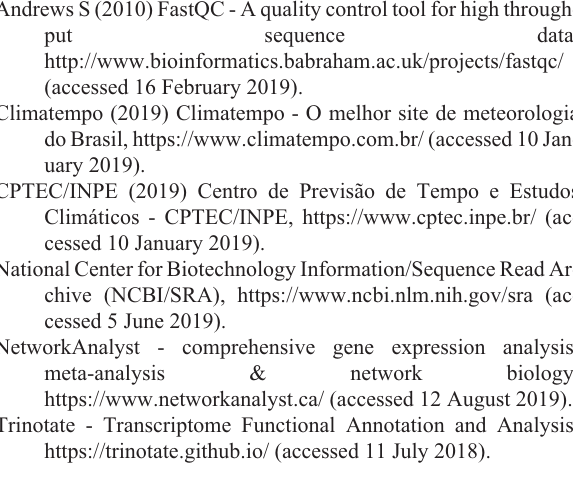
Table S1 - List of prior hubs that formed the biological net- work of the Balbina population. Table S2 - List of prior hubs that formed the biological net- work of the Brumado